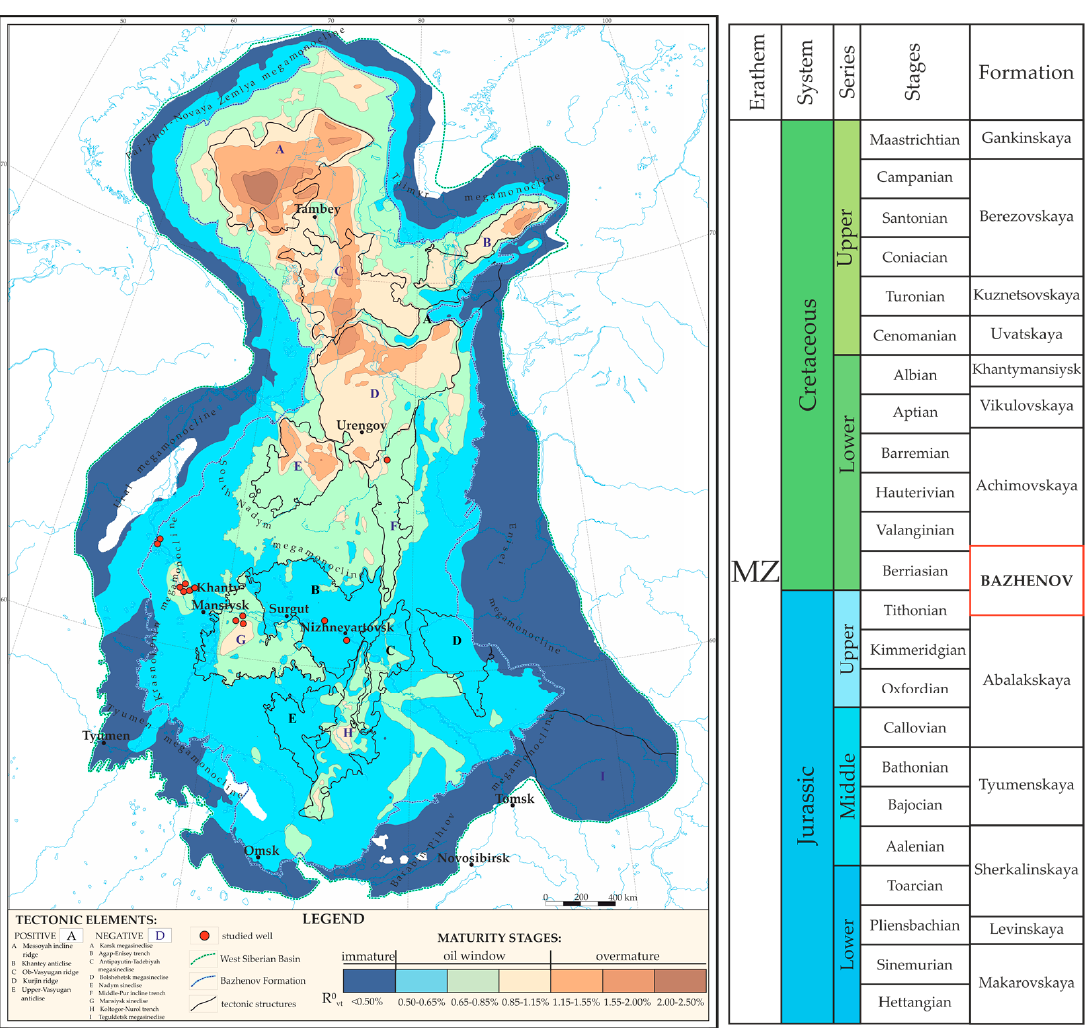
Figure 1. The geological map (modified after [27]) with location of studied wells and stratigraphic column.